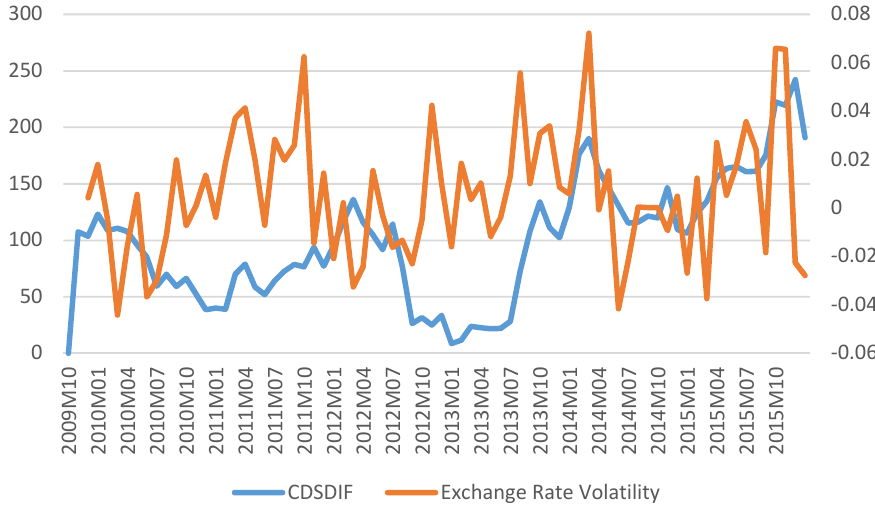
Figure 2. Volatility in nominal exchange rate (Right Axis) and Changes in CDS differential (Left Axis) (Volatility in nominal exchange rate calculated due to change compared to previous month, CDS differentials are in absolute value.).